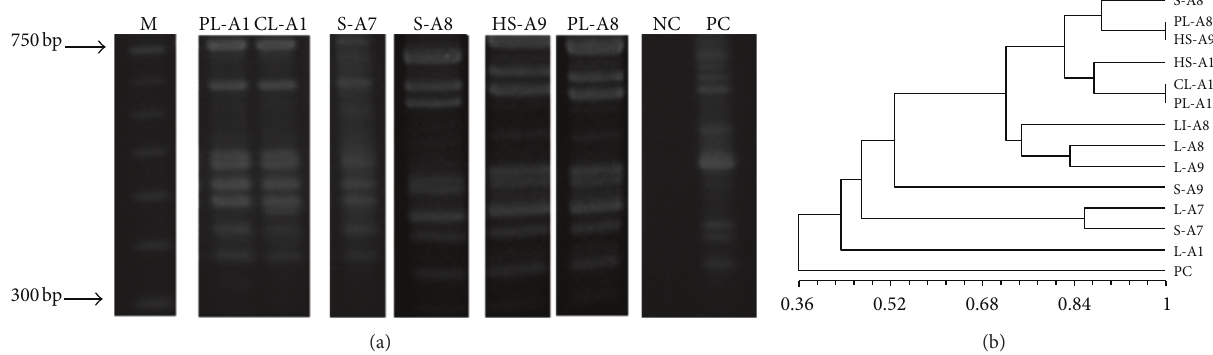
Figure 2: (a) Agarose gel electrophoresis showing similar and divergent representative genetic profiles generated by LSSP-PCR from parasites thatdisseminatetodifferentanatomicalsites.(b)PheneticanalysisusingtheJaccardcoefficientofsimilarityandUPGMAalgorithm.M:100 bp DNA ladder marker; NC: negative control; PC: positive control ( L. (V.) braziliensis reference strain MHOM/BR/1975/M2903). S-A8: spleen fragment from animal 8; PL-A8: popliteal lymph node fragment from animal 8; HS-A9: healthy skin fragment from animal 9; HS-A1: healthy skin fragment from animal 1; CL-A1: cervical lymph node fragment from animal 1; PL-A1: popliteal lymph node fragment from animal 1; LI-A8: liver fragment from animal 8; L-A8: lesion fragment from animal 8; L-A9: lesion fragment from animal 9; S-A9: spleen fragment from